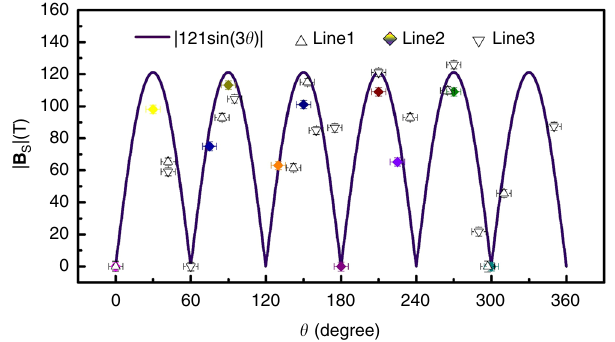
Fig. 4 Three-fold symmetric PMF as a function of rotational angles. The experimental | B S | data extracted from all diamonds and triangles on circle lines 1 – 3 in Fig. 3b exhibit a six-fold symmetric distribution, which can be well fi tted by the function | B S | = |121sin(3 θ )|, indicating the presence of three-fold symmetric PMF with alternating signs in GNB. Error bars represent the experimental uncertainties (s.d.) in determining the angles (in x -axis) and extracted | B y axis). Source data are provided as a S | values (in Source Data fi